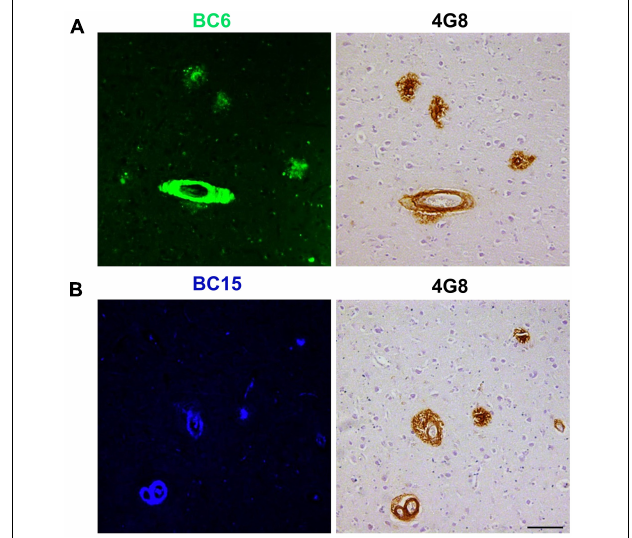
FIGURE 4 | 4G8-positive A β deposits were stained with BC6 and BC15. BC6 (50 µ M) (A) , and BC15 (1 mM) (B) staining of AD human brain frontal cortex was confirmed by the 4G8 immunohistochemical staining of the mirror image sections. The images of the dyes-staining were flipped horizontally to match the same location of the immunohistochemically-probed sections. Scale bar 100 µ